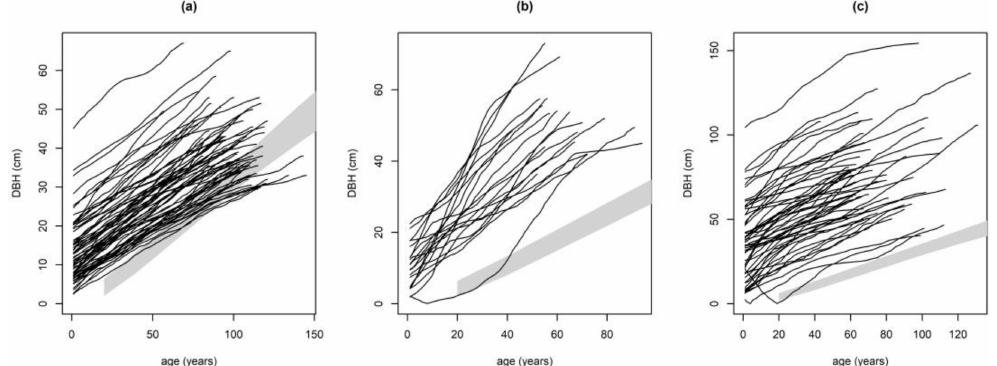
Figure 10. Observed diameter at breast height (DBH) over tree age (black lines) for study sites ( a ) Germany; ( b ) Italy; and ( c ) South Africa respectively. DBH is compared with the mean diameter range (grey shaded area), according to the yield table for oak (heavy thinning, site classes I–III) by Jüttner [72]. Yield table values are pictured on different scales for each